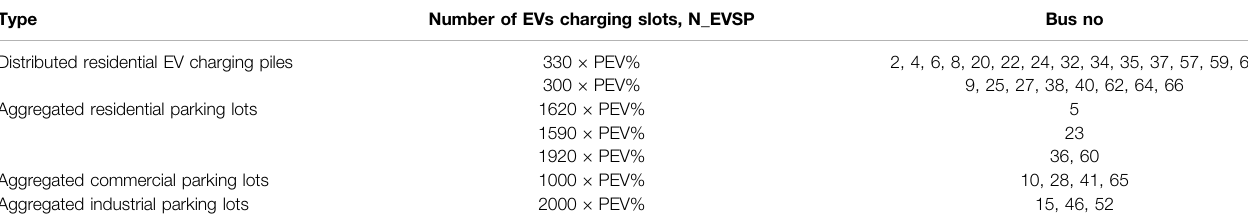
TABLE 4 | | Number of EV charging slots on each bus at PEV% penetration level.